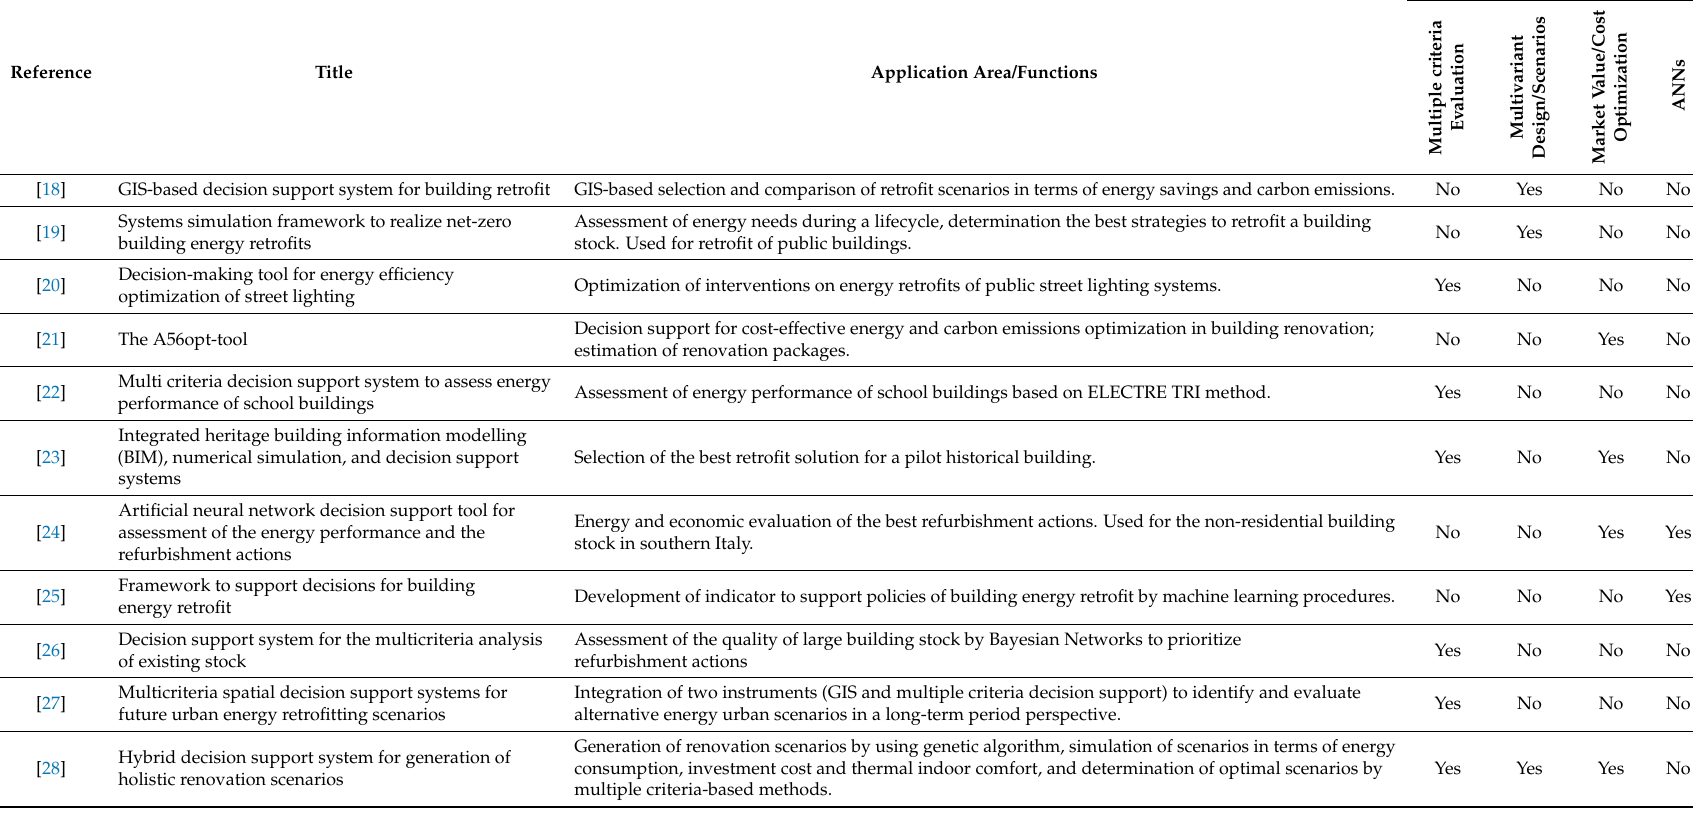
Table 1. Review of the energy-related decision support systems in the area of built environment. GIS—geographic information systems; ANN—artificial neural